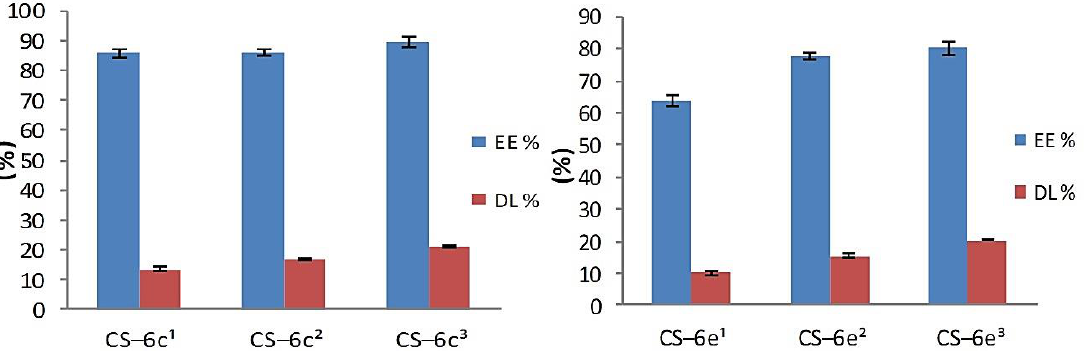
Figure 7. The Entrapment efficiency (EE%) and Drug loading (DL%) for CS–6c andCS-6e ( 1 = 3 mg/mL, 2 = 4 mg/mL, 3 = 5 mg/mL).